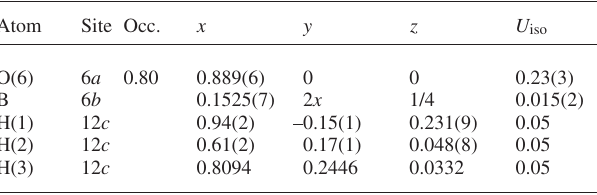
Table 2. Atomic coordinates and displacement parameters (in Å 2 )